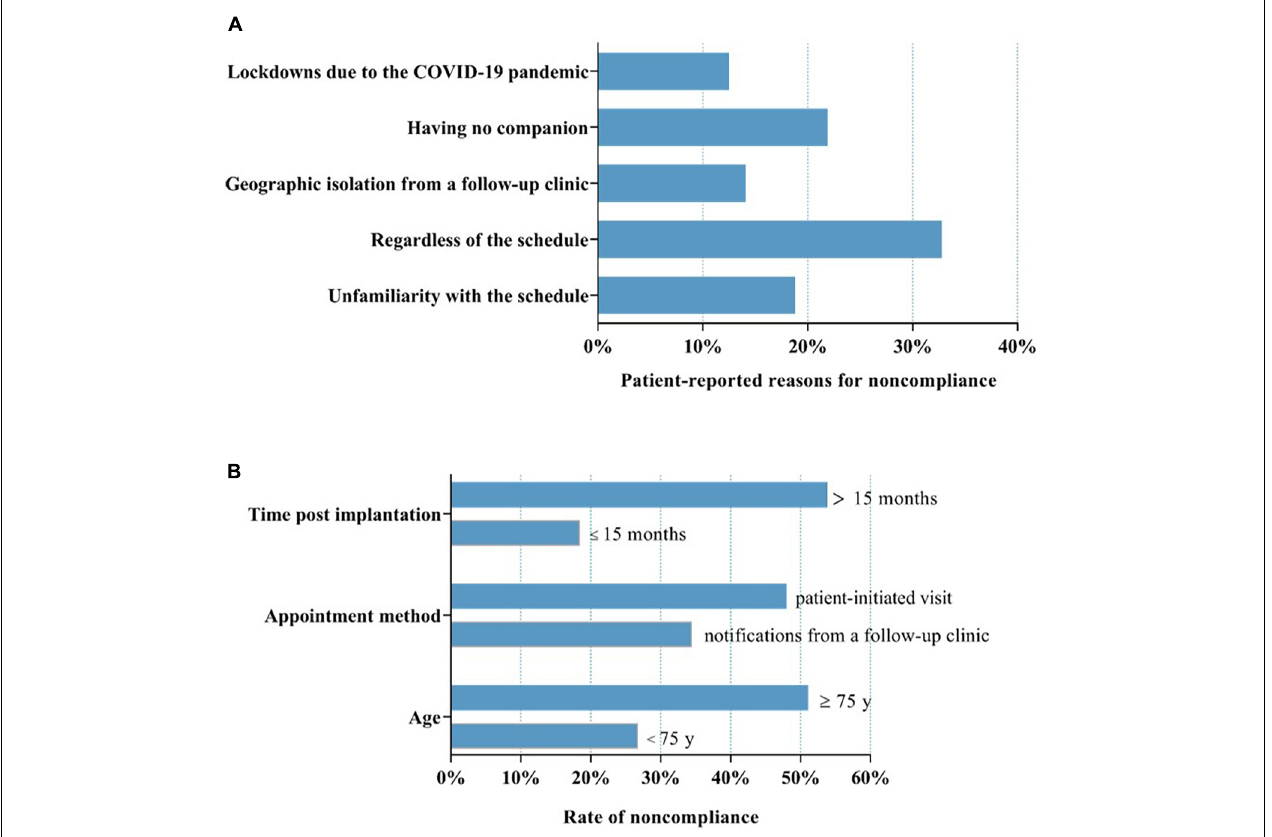
FIGURE 3 | Factors associated with non-compliance with routine in-office visits. (A) Patients who displayed non-compliance with routine in-office visits reported that regardless of the schedule because of no discomfort (32.8%), having no companion (21.9%), lack of familiarity with the follow-up schedule (18.8%), geographic isolation from the follow-up clinics (14.1%) and lockdowns due to the COVID-19 pandemic (12.5%) resulted in non-compliance. (B) Factors including age, appointment method and time post-CIED implantation were significantly associated with variations in non-compliance. COVID-19, coronavirus disease 2019. “Disregardness of the schedule” indicates the patients did not take routine in-office visit positively, and refused to finish it on time or even did not attend it. “Unfamiliarity with the schedule” means the patients were unfamiliar with the in-office visit arrangements, which made them fail in finishing the in-office visit on time or even miss